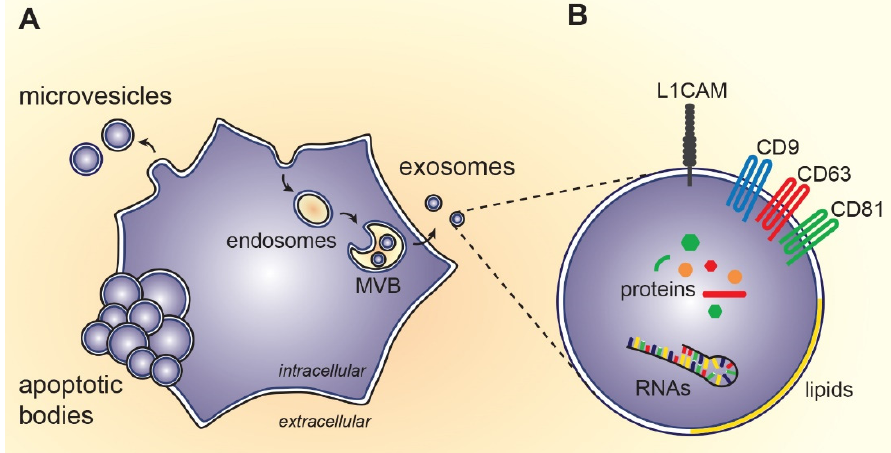
Figure 1. Biosynthesis and composition of extracellular vesicles: ( a ) Exosomes originate from endosomal compartment, i.e., intraluminal vesicles of multivesicular bodies (MVB). On the other hand, microvesicles arise by outward budding of cytoplasmic membrane and apoptotic bodies are formed during programmed cell death; ( b ) Exosomes contain proteins, RNAs, lipids and small molecules of the source cell. Some of the molecules specifically incorporated during exosome biosynthesis can be used as markers for exosome detection (e.g., transmembrane tetraspanins CD9, CD63, CD81) or as a marker of neuronal origin (e.g., L1 cell adhesion molecule, L1CAM).